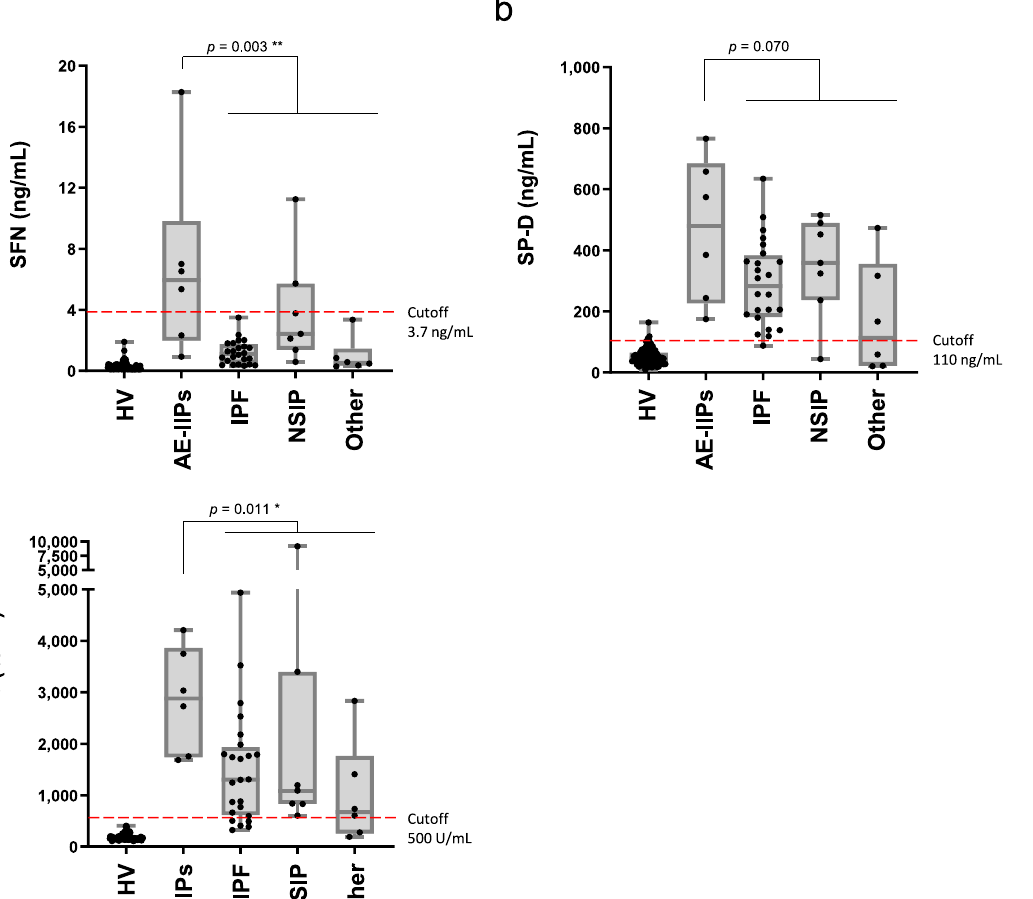
** p <0.01. The broken lines indicate the respective cutoff values. HV healthy volunteer, AE-IIPs acute exacerbation of idiopathic interstitial pneumonias (DAD- type disease), IPF idiopathic pulmonary fi brosis, NSIP nonspeci fi c interstitial pneumonia,Otherothertypesofidiopathicinterstitialpneumonia.Sourcedataare provided as a Source data fi